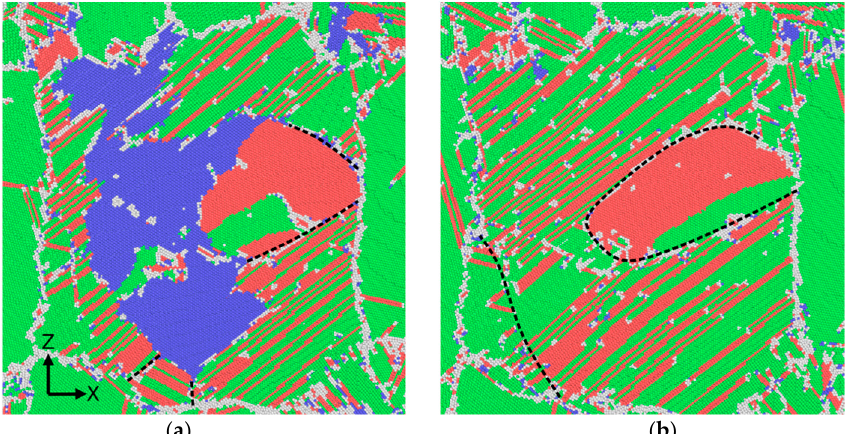
Figure 9. Cross-section of a lamella of the large grain by the bcc ( 1(cid:3364)10 ) plane parallel to the bcc/fcc interface at the compressive strains 15.00 ( a ) and 20.00% ( b ). Atoms with bcc, fcc, hcp and uncertain nearest neighbor symmetry are shown in blue, green, red, and light gray, respectively. Fragment boundaries are marked off by dashed lines.